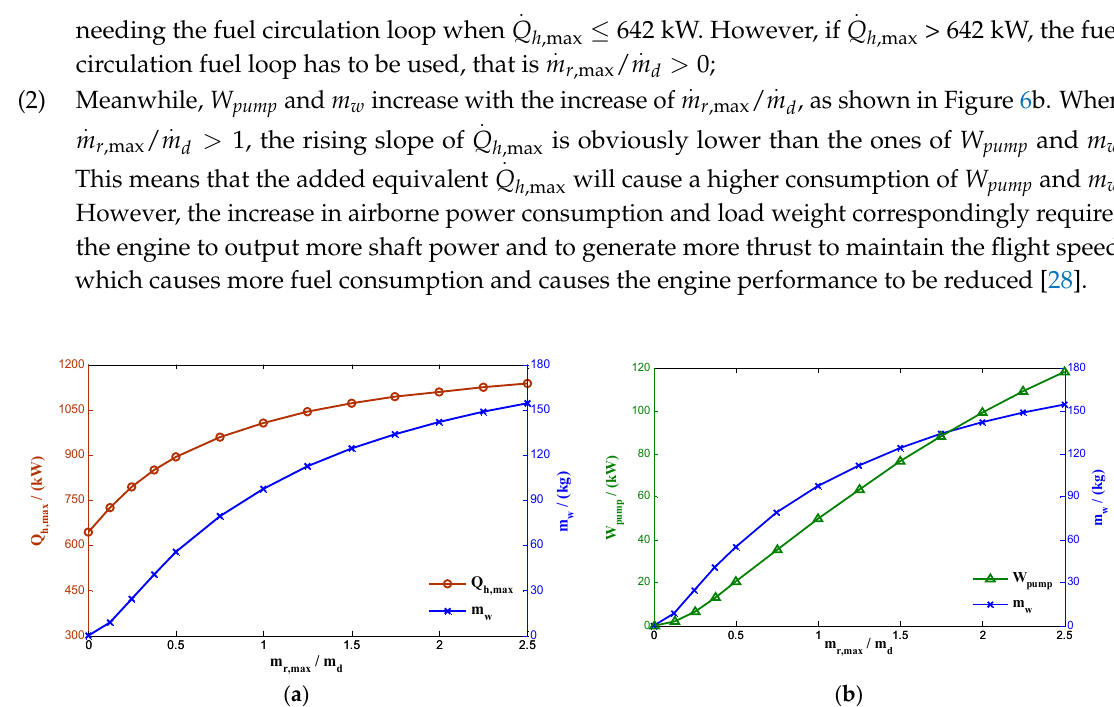
. m m   . . . . Q  m r ,max / m d and Q h ,max ; ( b ) m r ,max / m d and ,max h ; ( b )